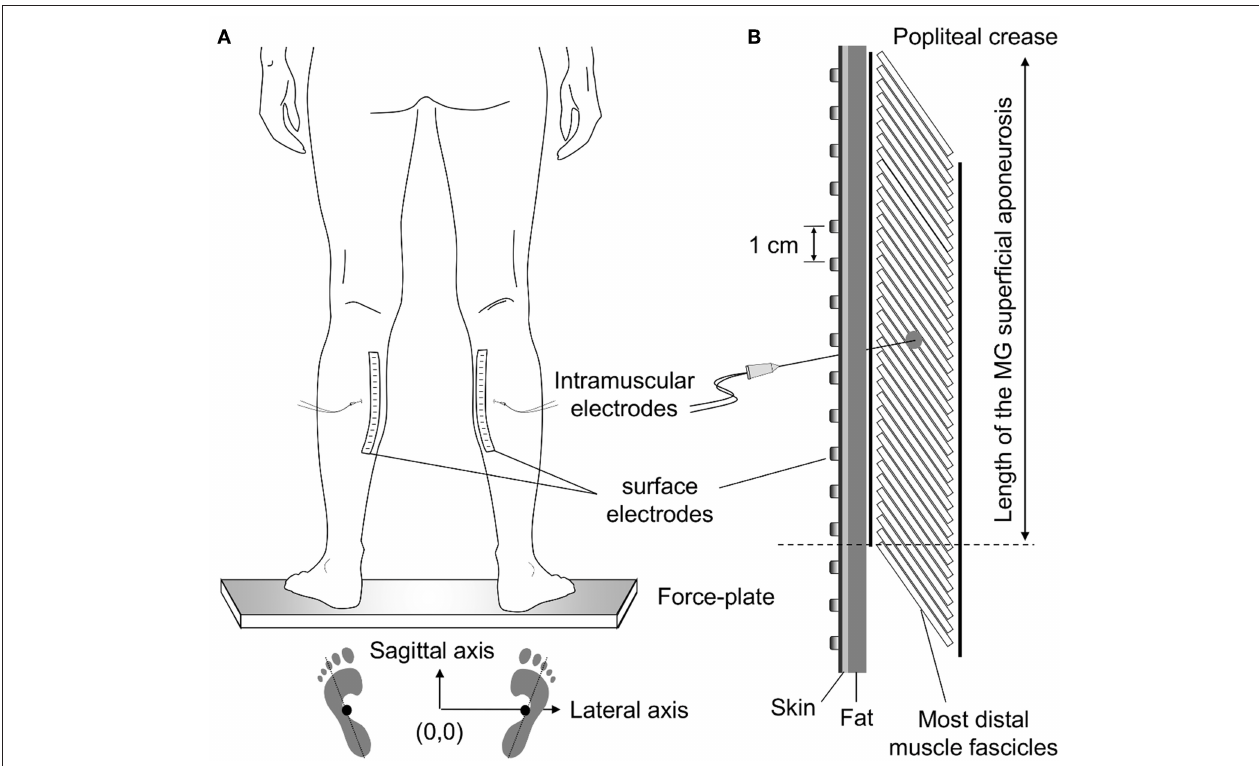
FIGURE 1 | Standing posture and electrode positioning. While individuals stood at a comfortable stance (A) the feet position was marked on the force plate. These drawings were considered to quantify the approximate center of pressure (CoP) position corresponding to a symmetric weight distribution between limbs (see Methods, section Experimental Protocol). (B) shows the relative position between medial gastrocnemius (MG) and surface and intramuscular electrodes. Wire electrodes were inserted at the MG region corresponding to the central location between the most proximal, surface electrode, and the distal extremity of the superficial aponeurosis (see dashed line); for the example illustrated in panel (B) , this region roughly corresponds to the position of the sixth electrode from top to bottom. The length of MG superficial aponeurosis was estimated as the distance between its distal extremity and the popliteal